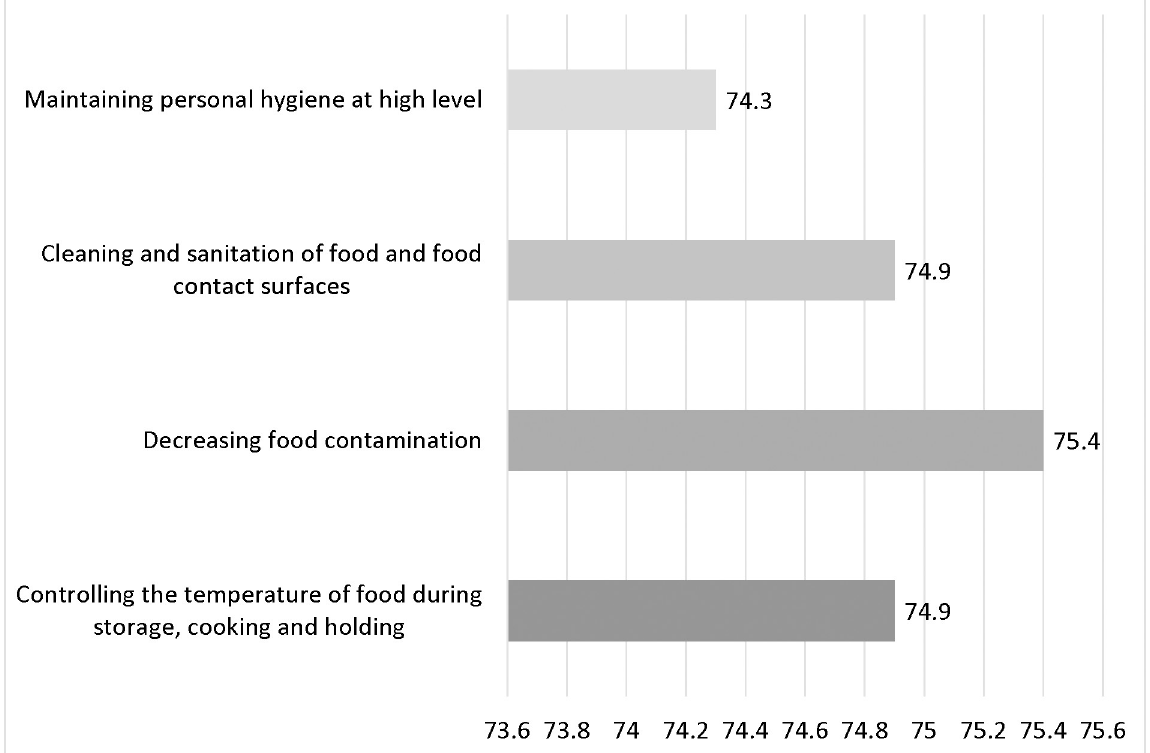
Fig 4. Participants who answered ’Yes’ to “Did the COVID-19 pandemic enhance your food safety measures in the following aspects?” (n = 325).